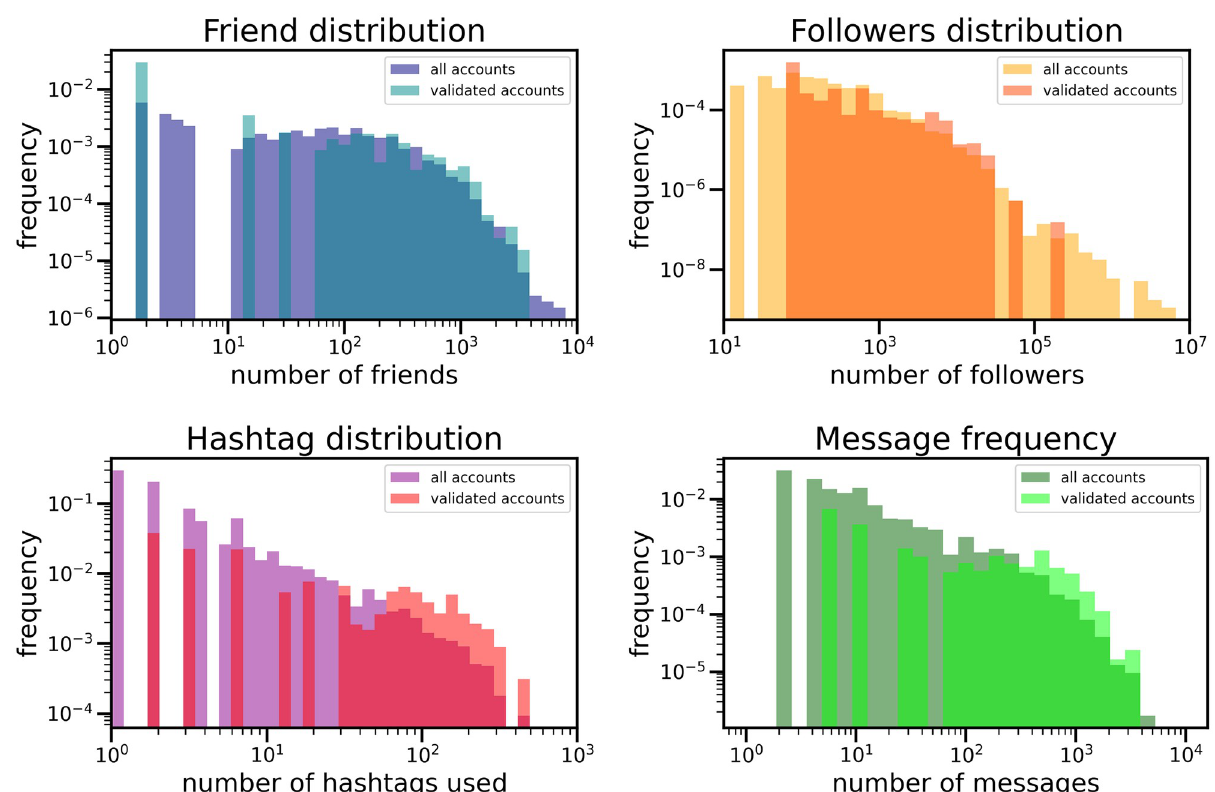
Fig 3. Properties of nodes in the validated network vs. the ones in the entire set. The various distributions show that the validated accounts are those that have a greater number of friends (top left panel), use greater number of hashtags (bottom left panel) and write more messages (bottom right panel). Interestingly enough, the validated nodes are not the most popular, i.e. those with the highest number of followers (top right panel). In order to check the most popular accounts, we focused on accounts with more than 10 6 followers. In fact, the number of their messages is extremely limited, while their use of hashtags is extremely focused on their activities. This may be related to their strategies, to remark the exclusiveness of their products. More details can be found in the main